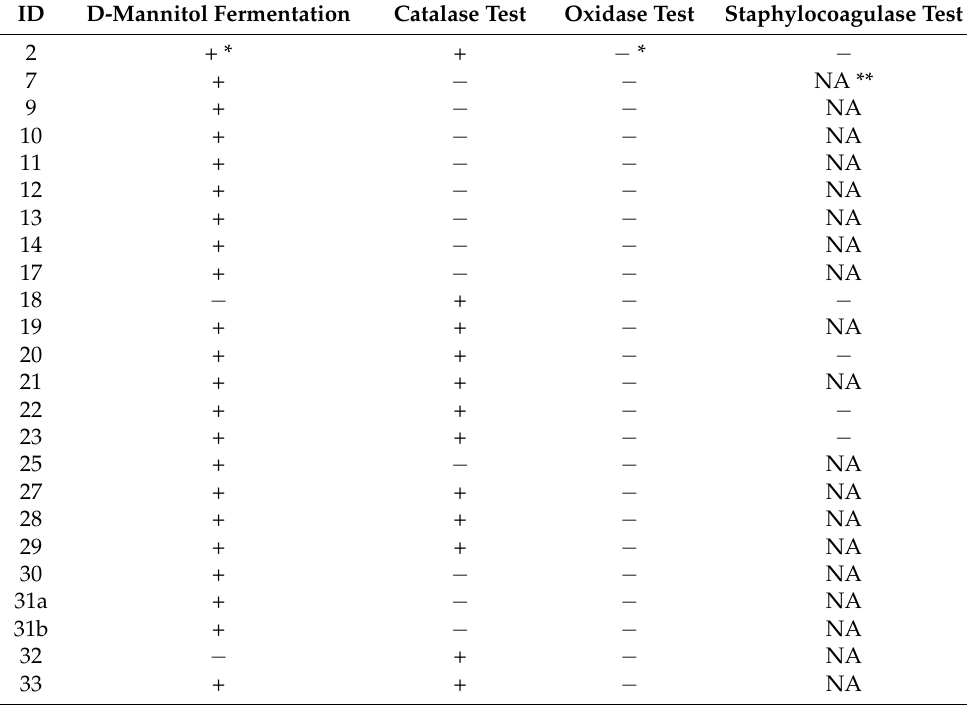
Table 1. Phenotypic features of bacteria isolated on MSA from wild boar nasal swabs.